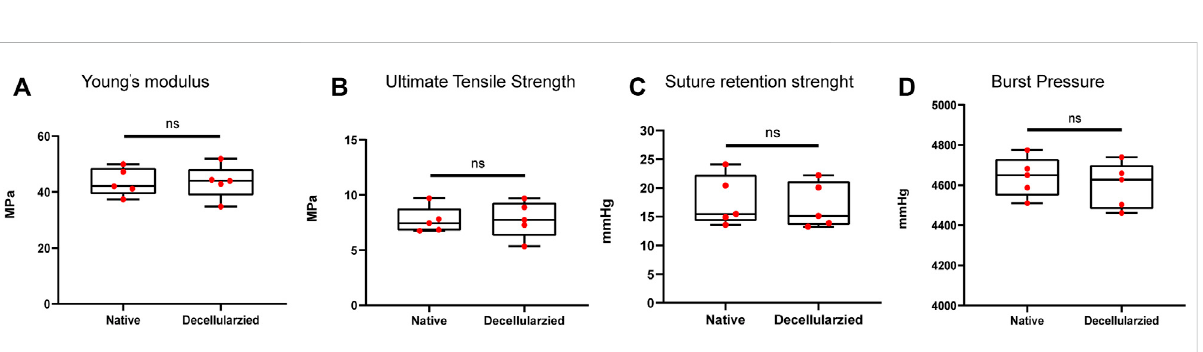
FIGURE 3 Full preservation of the mechanical properties of bovine internal mammary artery (BIMA) after decellularization. (A) Young ’ s modulus. (B) Ultimate Tensile Strength. (C) Suture retention strength. (D) Burst pressure. * p < 0.05. ** p < 0.01. ns represents no signi fi cant difference.